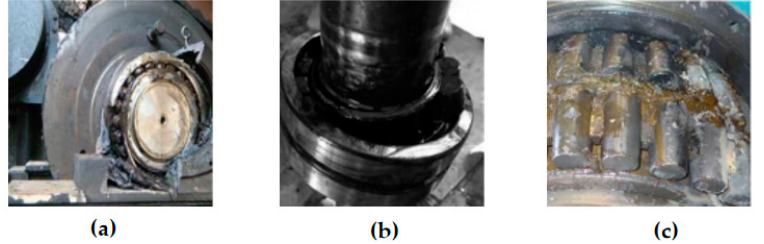
Figure 8. Bearing Lubrication Failure Mode [91–93]. ( a ) Bearing failure due to excessive lubrication; ( b ) Bearing failure due to lubricant deterioration; ( c ) Bearing failure due to insufficient lubrication.